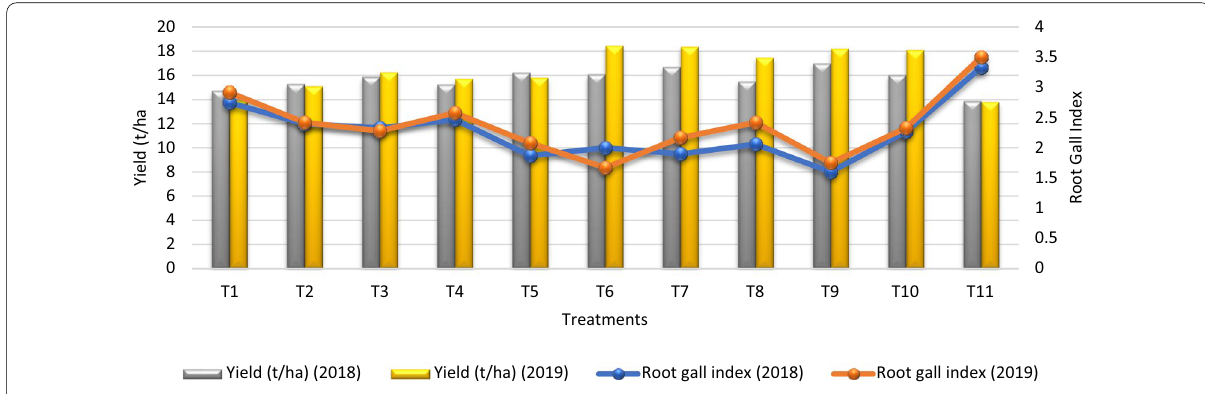
Fig. 4 Trend of root galling and yield attained during 2018 and